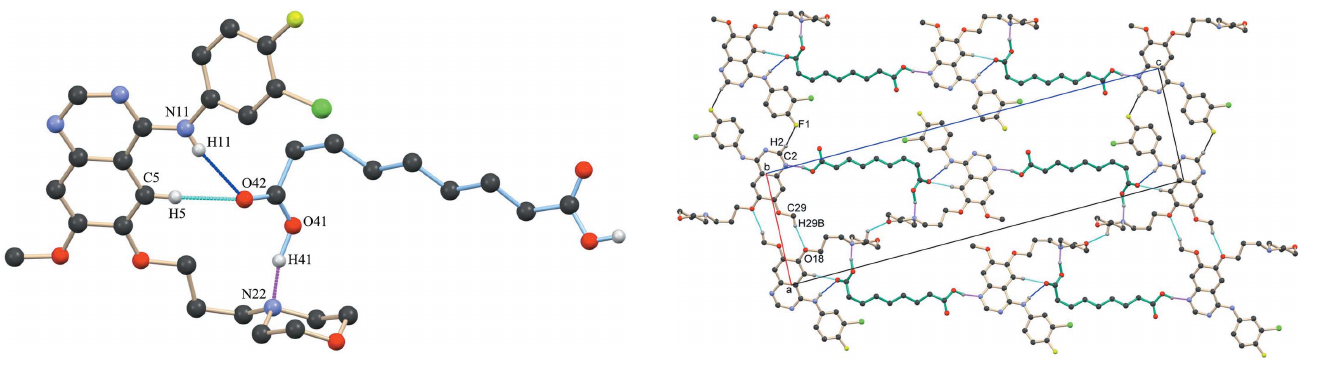
Figure 6 Two-dimensional layered assembly of GTB and AA along the ac